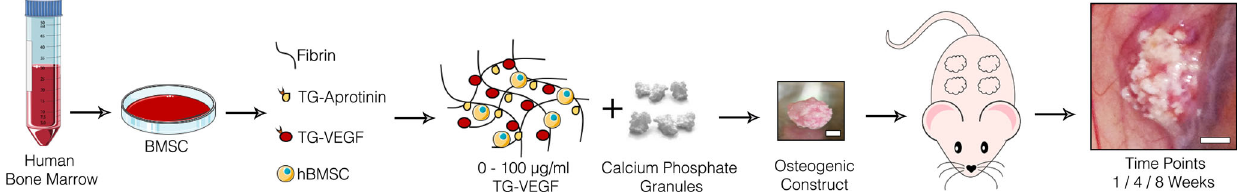
Fig. 1 Study design for the ectopic model of bone formation. Osteogenic constructs were generated by combining in vitro expanded human BMSC with calcium phosphate granules in a fi brin hydrogel decorated with different doses of TG-VEGF, ranging from 0 to 100 µg/ml; scale bars = 2